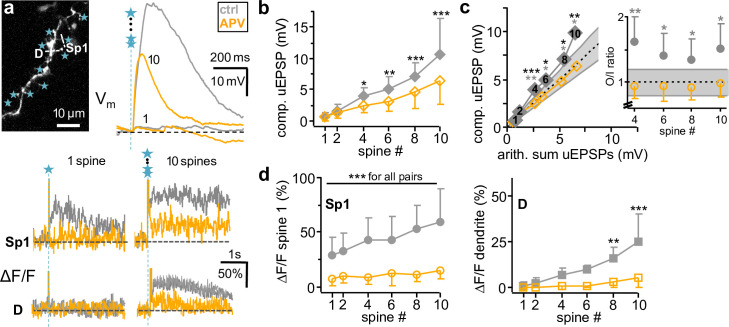
Molecular mechanisms of subthreshold integration: NMDA receptors.a: Example NMDAR blockade experiment with strong NMDAR component. Top left: Stimulated spine set with line scan sites Sp1, D, and uncaging spots. Top right: Somatic Vm recording of uEPSP, below spine (Sp1), and dendrite (D) ΔF/F for 1 and 10 spines. Gray traces: control. Yellow traces: APV (25 μM). b: Cumulative effect (n = 8 cells) of 25 μM APV on somatic cuEPSP amplitude upon activation of 1, 2, 4, 6, 8, and 10 spines. Interaction effect (spine # x APV): F(5,95) = 8.08, p < 0.001. Black asterisks: significance of difference APV versus control. c: Effect of NMDAR blockade on averaged sO/I upon activation of 1–10 spines. Interaction effect (spine # x APV): F(5,95) = 3.37, p = 0.014, n = 8. Black asterisks above data points: significance of difference APV versus control. Lines and grey asterisks as in Fig 1C. Control O/I ratios from 4 spines upwards were supralinear, which all became linear in APV. d: Effect of NMDAR blockade on average ΔF/F in Sp1 (left, n = 15 spines) and D (right, n = 8) upon activation of 1–10 spines. Interaction effect on spine ΔF/F (spine # x APV): F(5,179) = 6.36; p < 0.001. Interaction effect on dendrite ΔF/F (spine # x APV): F(5,95) = 8.34, p < 0.001. Asterisks: significance of difference APV versus control; arith., arithmetic; comp., compound; cuEPSP, compound uncaging-evoked excitatory postsynaptic potential; sO/I, subthreshold output/input.